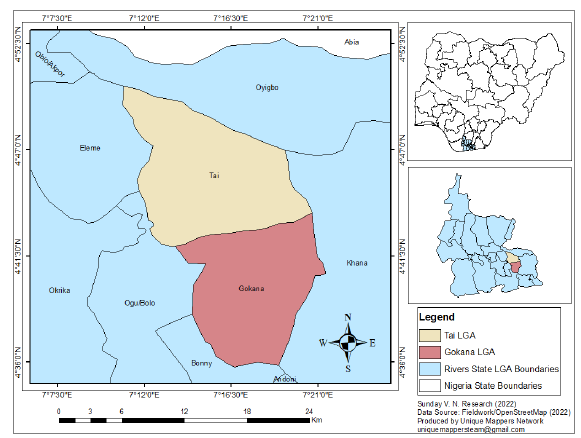
Figure 2: Tai and Gokana LGA Study Location in Rivers State,